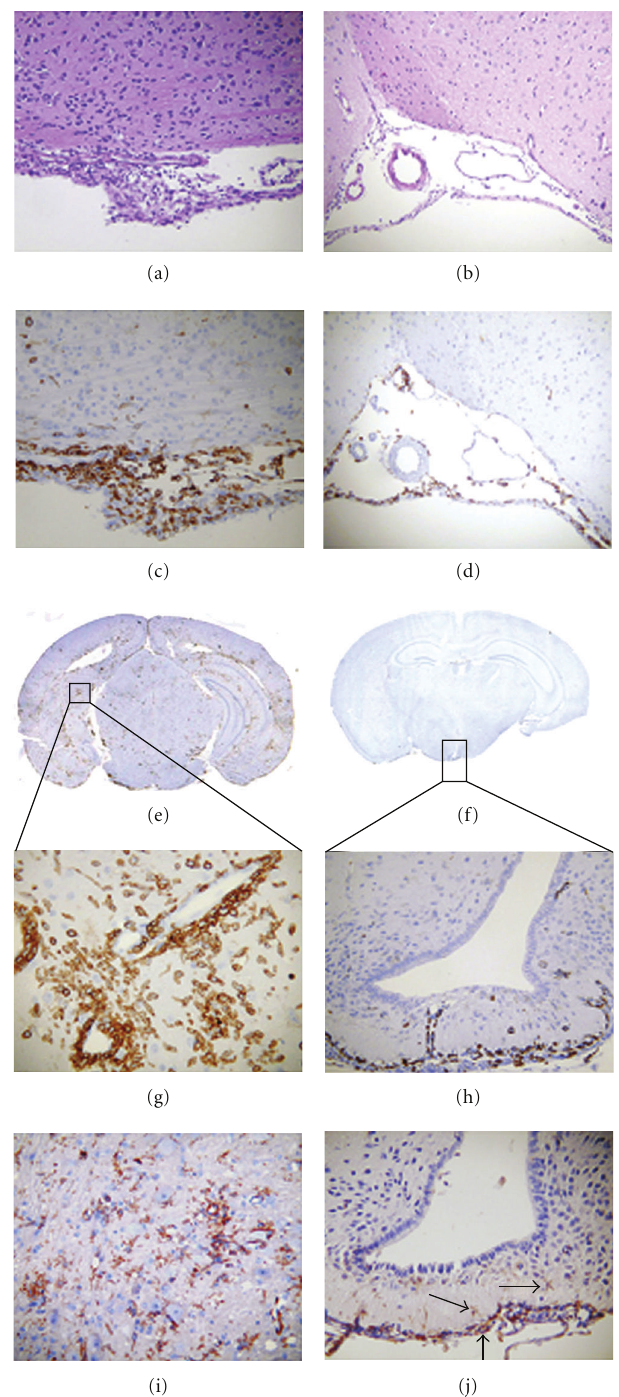
Figure 5: Histopathology of brain sections during acute infection with MHV-A59 compared to MHV-2. 5 μ m thick serial coronal sections from MHV-A59- and MHV-2-infected mice at day 5 post inoculation were stained with H & E (a, b) or immunostained for LCA (c–h) or CD11b (i, j). Histopathology shows acute meningitis characterized by brisk leptomeningeal inflammatory infiltration in the subarachnoid space of the basal forebrain in both MHV-A59- (a, c) and MHV-2-infected (b, d) mice. Coronal sections stained for LCA show acute encephalitis in MHV-A59-infected mouse brain characterized by the presence of inflammatory infiltrates throughout the parenchyma (e) and formation of perivascular cu ffi ng (g) in high magnification whereas in MHV-2 infection infiltrating inflammatory cells were rarely observed in brain parenchyma (f) and, when present, were restricted to the subependyma (h). The majority of LCA+ inflammatory cells stained positive for the macrophage/microglia marker CD11b in MHV-A59-infected brain parenchyma (i) and the few positive cells in MHV-2-infected brain (j) remained restricted to subependyma (arrows). Original magnifications for (a–d) and (h) are 100x, for (g, i, and j) are 200x, and for (e) and (f) are laser-scanned images. (adapted from the work of